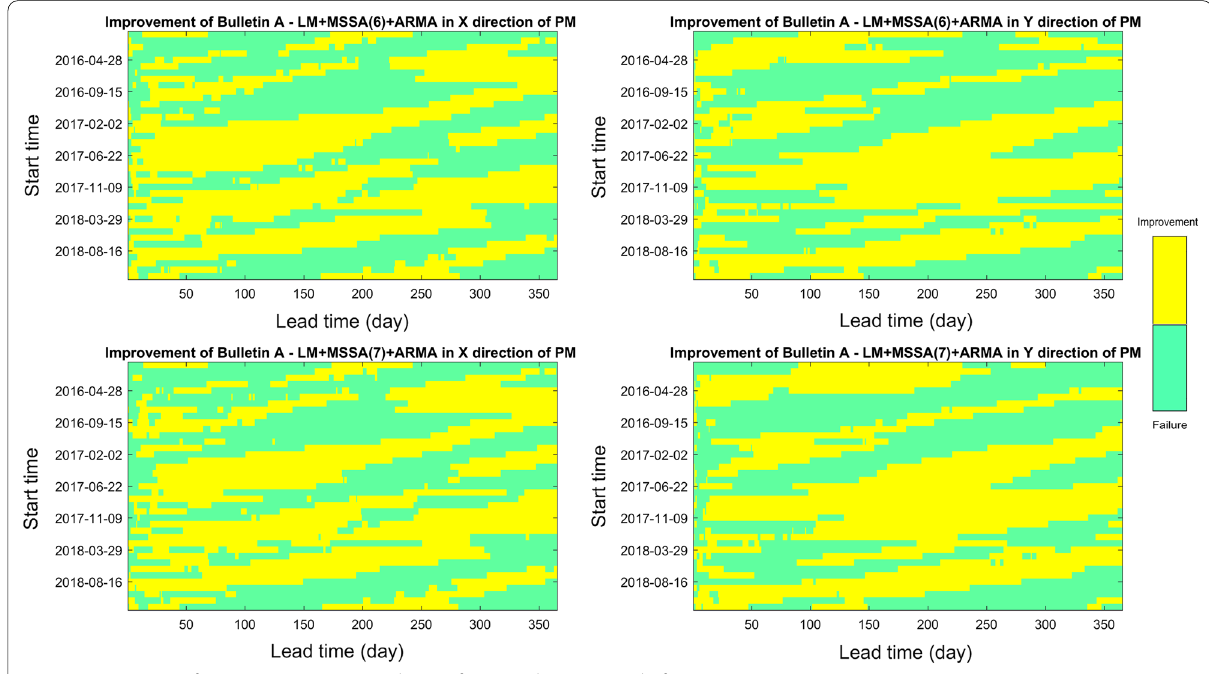
Fig. 9 Comparison of improvement in PM prediction (forecasted every 4 weeks from 2016 to 2018)